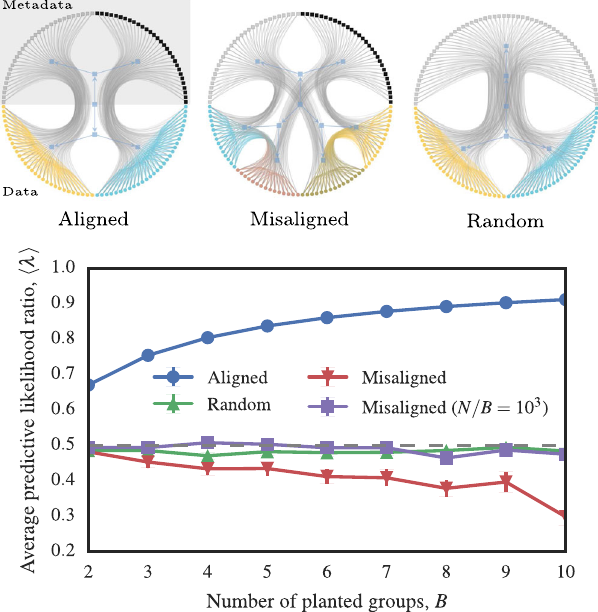
FIG. 4. Top: Examples of artificial annotated networks, show- ing aligned, misaligned, and random metadata, as described in the text. Bottom: Node prediction performance, measured by the likelihood ratio h λ i , average over all possible single-node removals, for annotated networks generated with B d ¼ B t ¼ B groups, N ¼ M ¼ 30 B nodes and tags, E ¼ E m ¼ 5 N node-node and tag-node edges, with specific network construction given by the legend. One of the curves corresponds to networks with misaligned metadata with a larger number of nodes, N ¼ M ¼ 10 3 × B